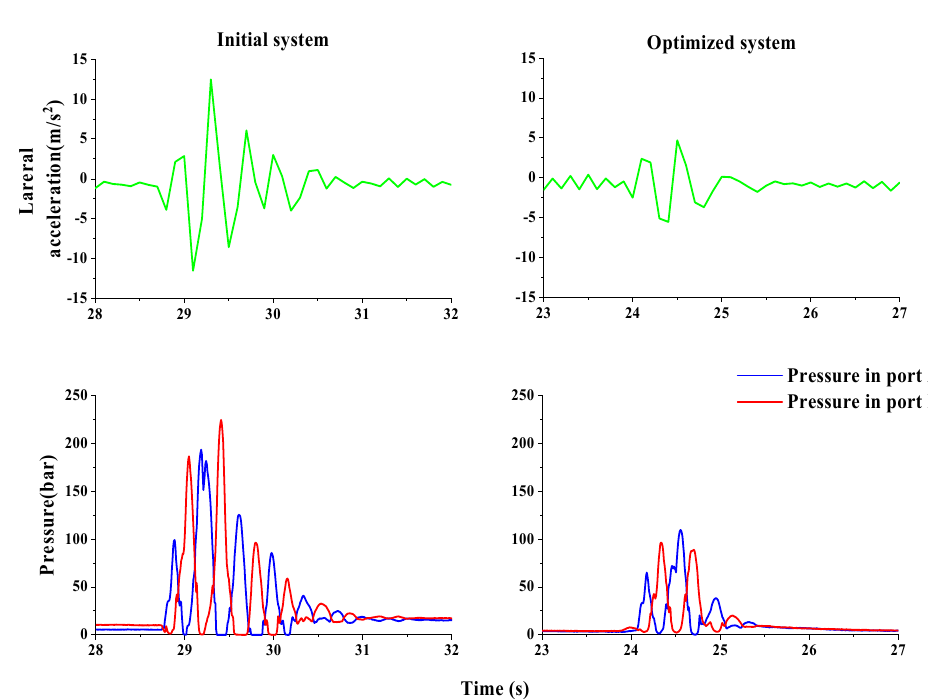
Figure 13. Test results steering emergency stop.